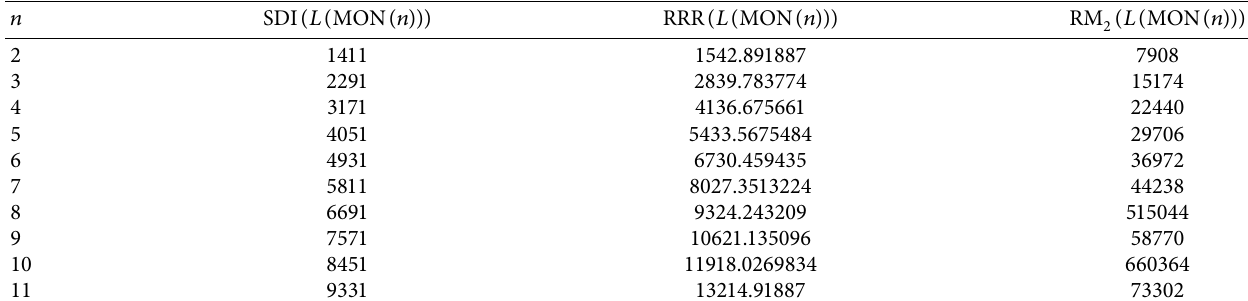
Table 2: Comparison of symmetric division, reduced Randi´c, and reduced second Zagreb.